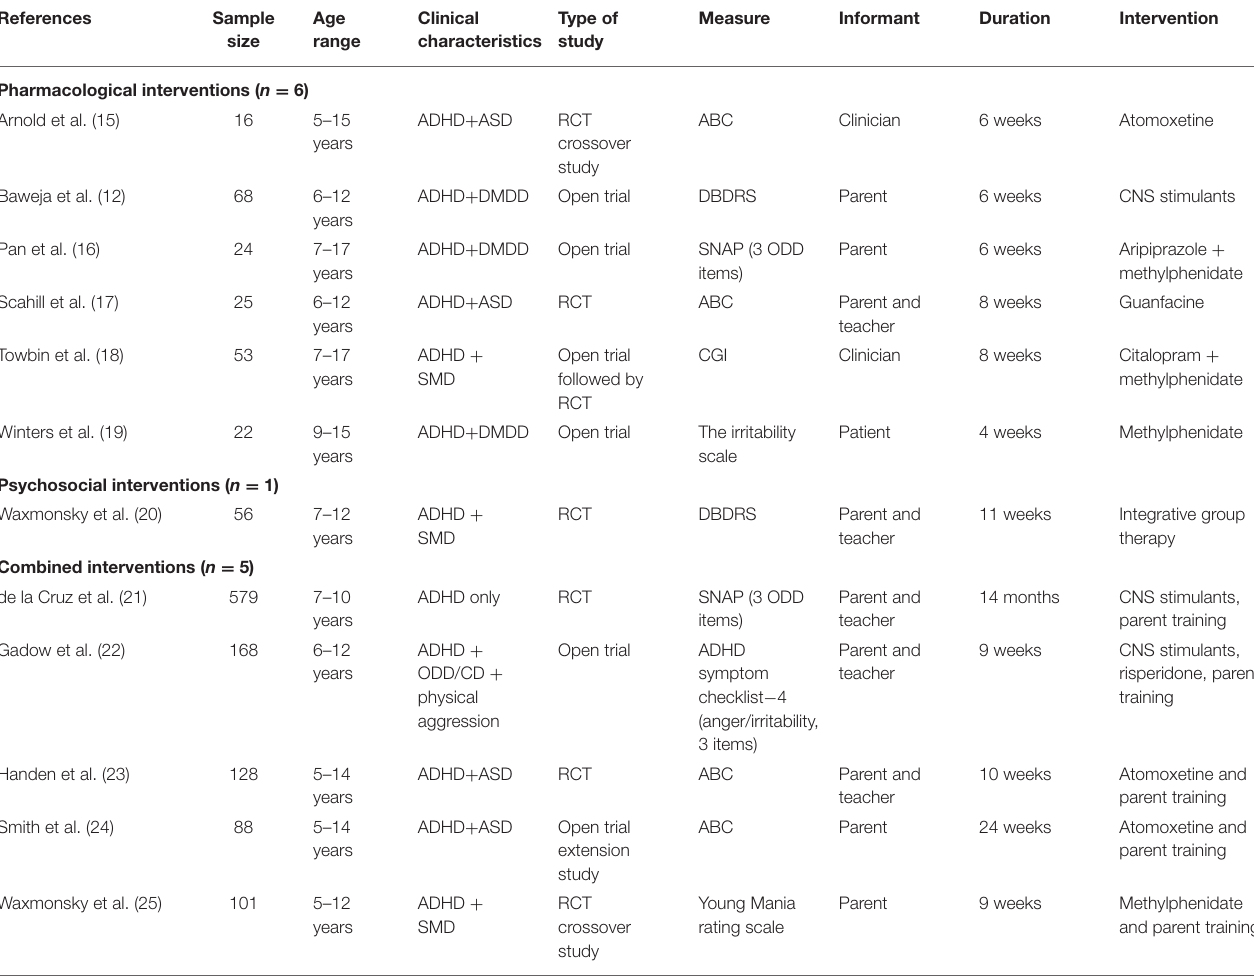
TABLE 1 | Articles targeting irritability in youth with ADHD included in the mini review ( N =